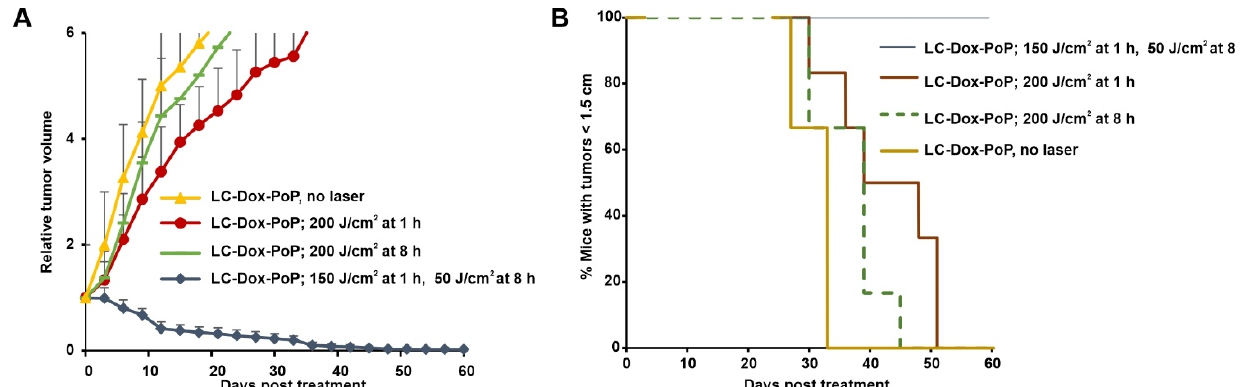
Figure 5. Impact of a second laser treatment for pancreatic PDX tumors. SCID mice bearing low-passage human pancreatic PDX tumors were treated with 3 mg/kg LC-Dox-PoP liposomes and treated with a 665 nm laser with a first treatment of 150 J/cm 2 at a 1 h·DLI and second laser treatment with 50 J/cm 2 , or alternatively with a laser single treatment of 200 J/cm 2 at a 1 h or 8 h·DLI. ( A ) Relative tumor growth. Data show mean ± std. dev. for n = 6 mice per group. ( B ) Percentage of mice with tumors < 1.5 cm over time.